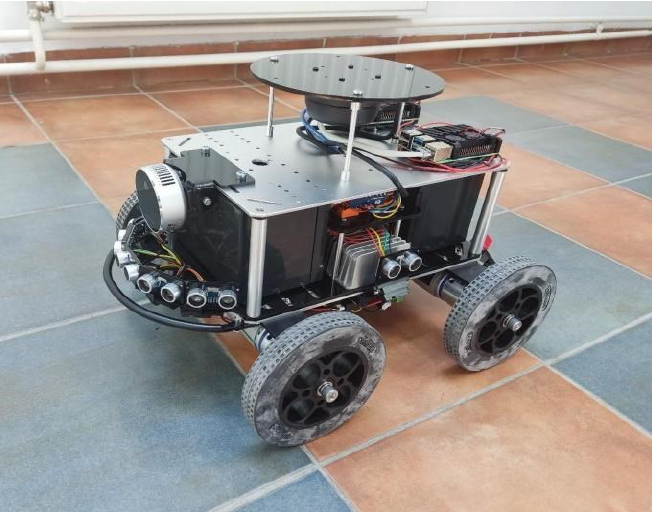
Figure 3. The first prototype of FireBot.